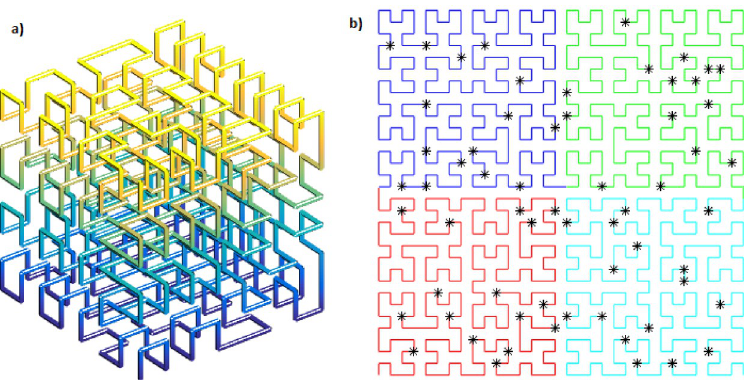
Fig 6. Examples of the Hilbert curves. (a) 3D Hilbert curve and (b) 2D Hilbert curve and particles randomly distributed in regions.